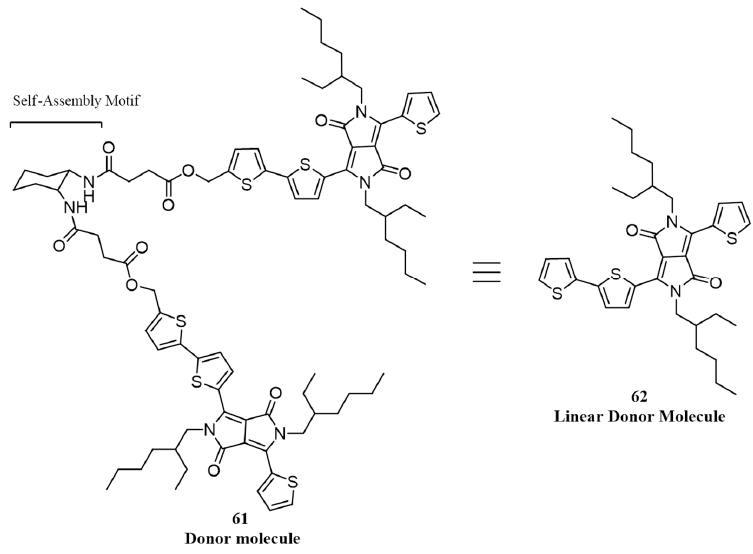
Figure 23. Chemical structures of 61 and 62 synthesized by Stupp et al. [84].